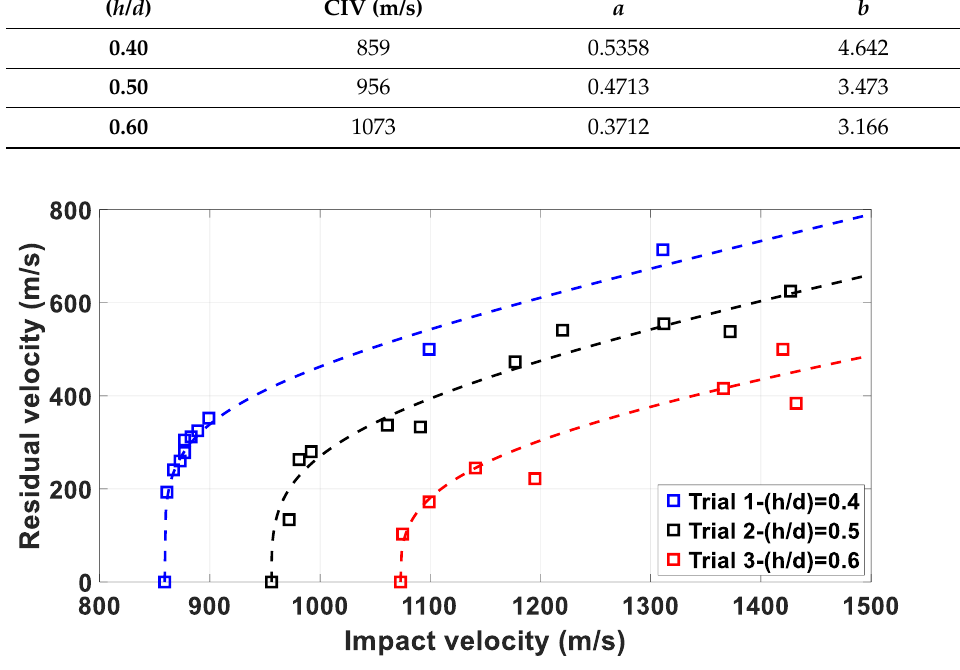
Figure 12. Recht Ipson curve fittings for 5 mm fragments impacting targets with values of α lower than 30°. The RI curves indicate that the increase of thickness of the plates from 2 mm to 2.5 mm results in residual velocities circa 20% lower, while the increase from 2.5 mm to 3 mm plates results in a decrease of circa 30%, indicating an average increase of 5% in velocity loss per additional millimetre.